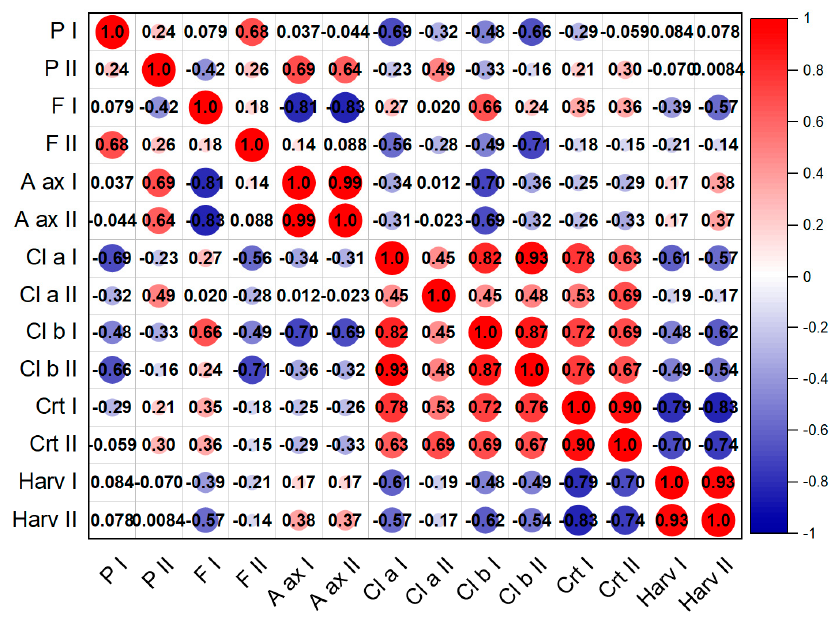
Figure 8. Pearson correlation matrix for the first harvest in 2020 and 2021 in Nepeta racemosa Lam. variants.